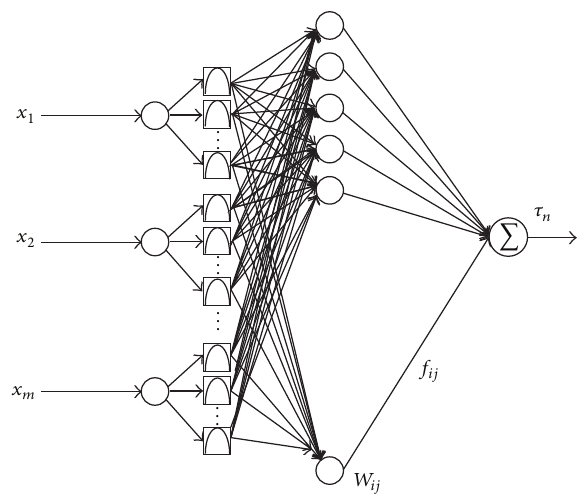
Figure 2: Structure of the proposed